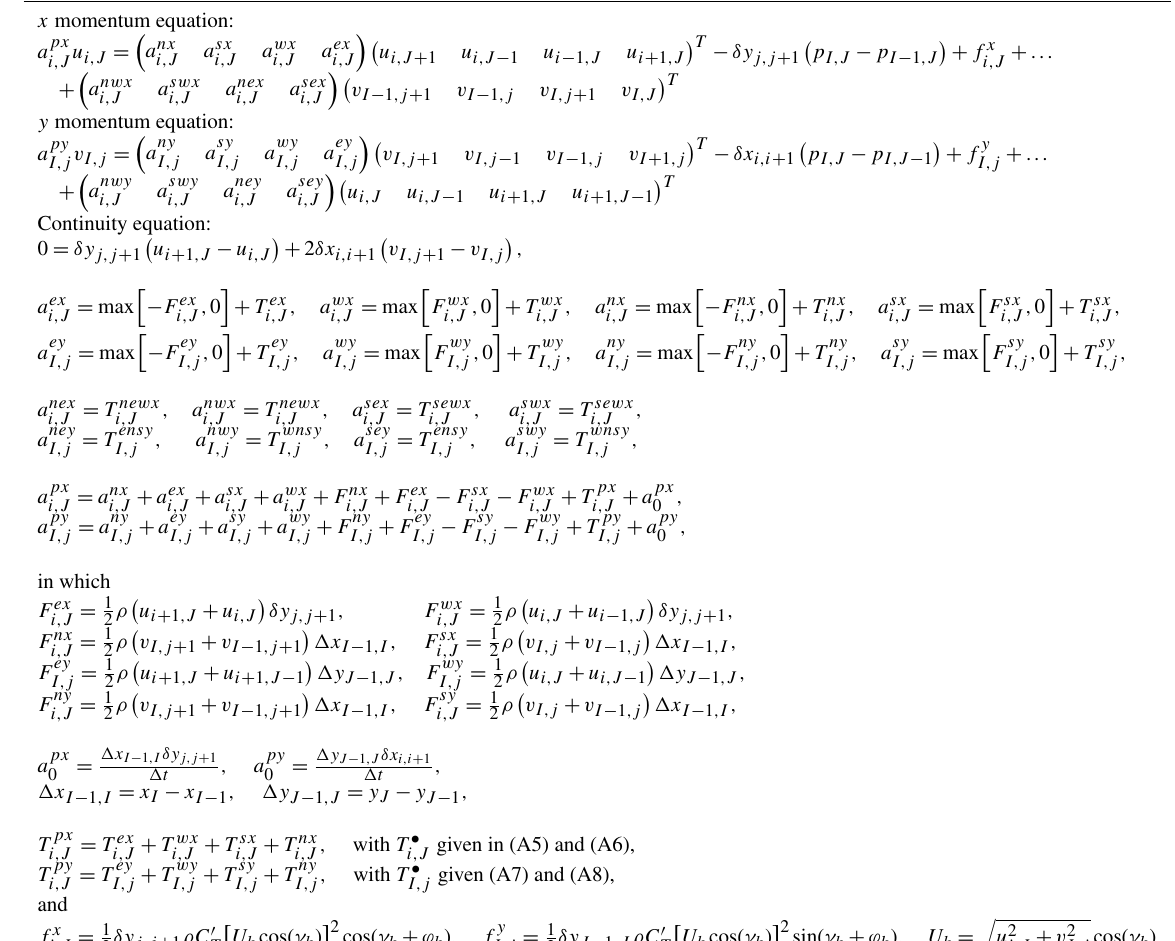
Table A1. Fully discretized Navier–Stokes equations and all their